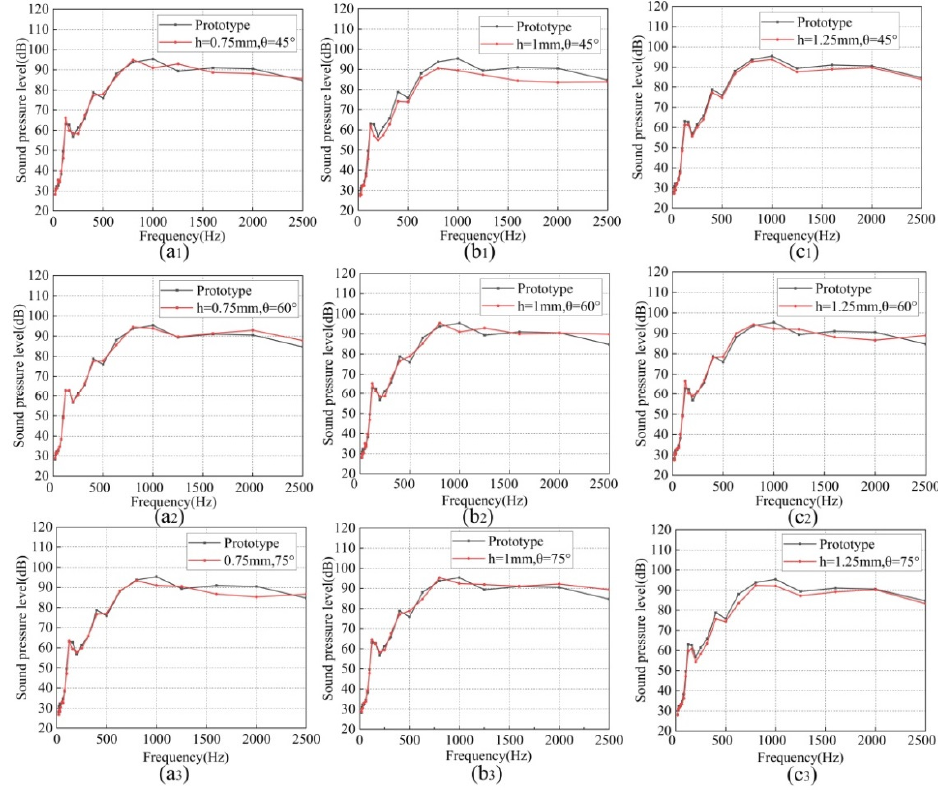
Figure 20. Sound pressure level curves at different size parameters: ( a 1 – a 3 ) texture height h 0.75 mm and top angle θ 45 °– 75 ° , ( b 1 – b 3 ) texture height h 1 mm and top angle θ 45 °– 75 ° , ( c 1 – c 3 ) texture height h 1.25 mm and top angle θ 45 °– 75 ° .